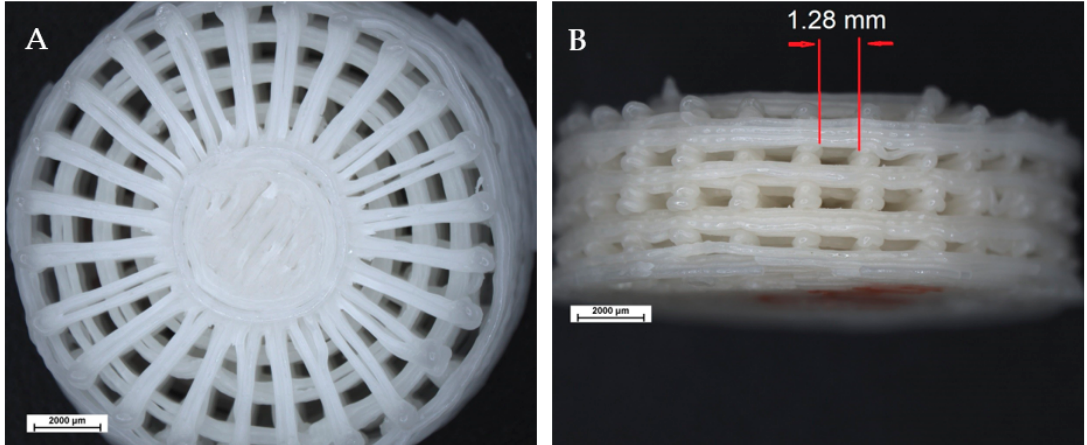
Figure 7. A representative bi-layer sample from the top ( A ) and side ( B ) views.